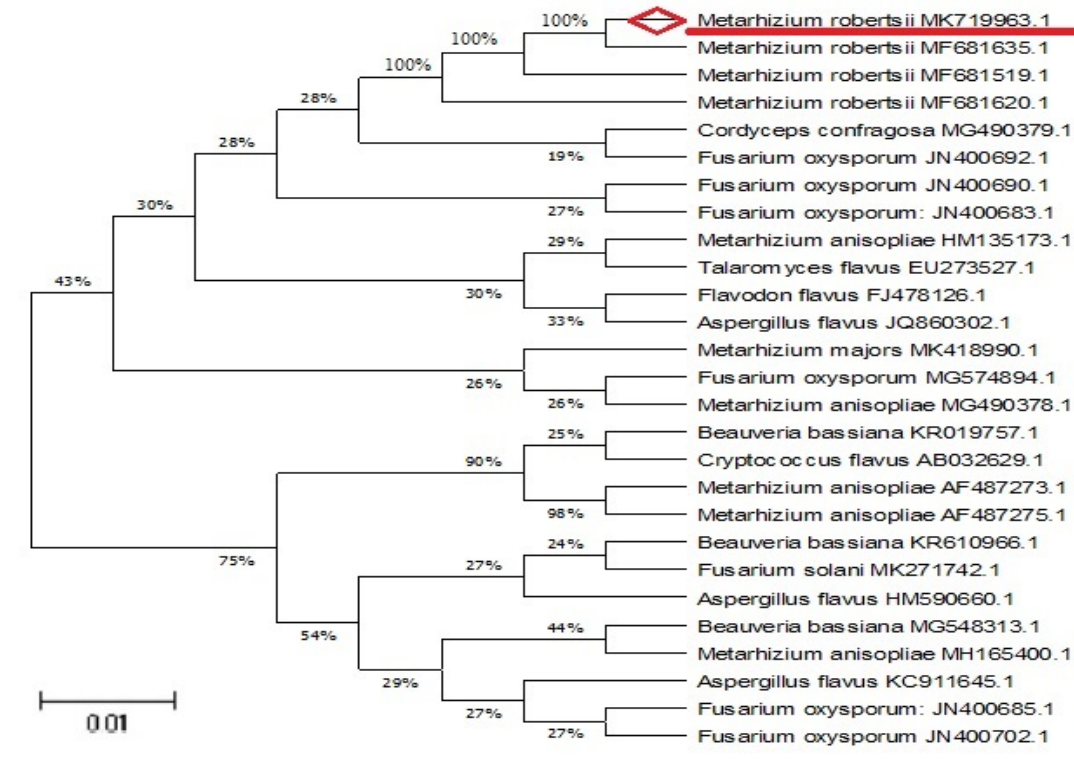
Figure 2. Neighbor-joining tree of the M. robertsii (MK719963.1) species closely related to the M. robertsii fungi.